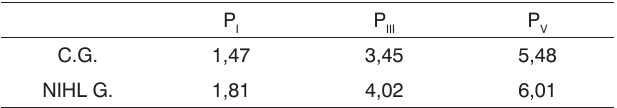
Table 5. Distribution of the absolute latencies of PI, PIII and PV of the left ear, in both groups and “p” value by the Mann-Whitney test.